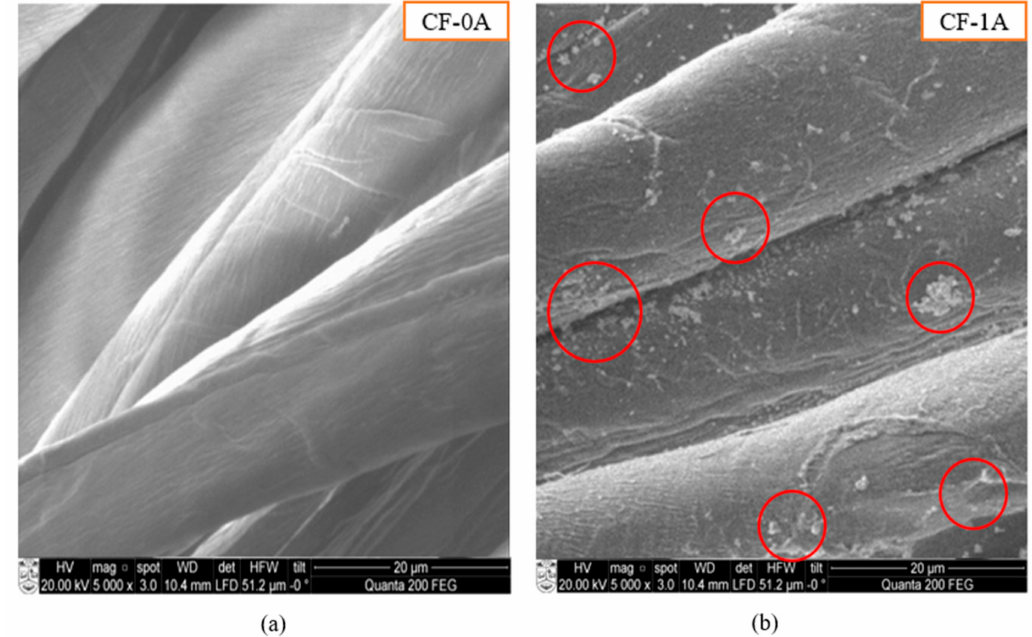
Figure 3. SEM images of the dyed cotton fabric: ( a ) without deposition of AgNPs (CF-0A); and ( b ) with deposition of AgNPs